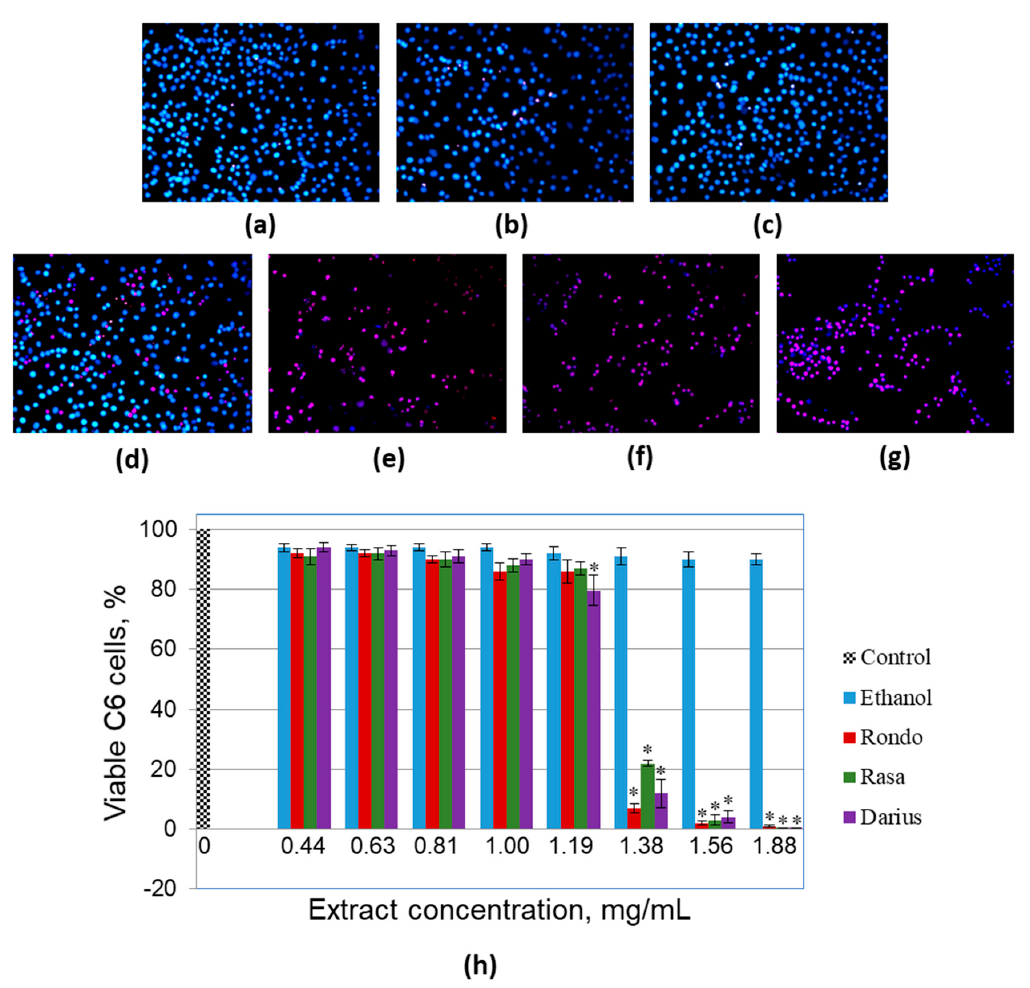
Figure 2. The effect of the extracts from leaves of different Japanese quince cultivars on viability of glioblastoma C6 cells. ( a – g ) Characteristic images of Hoechst/propidium iodide staining of the C6 cell nuclei after extract treatments; ( a ) samples treated with 125 µL/mL of the solvent ethanol (amount corresponds to 1.88 mg/mL extract treatment); ( b ), ( c ) and ( d ) treated with 1.19 mg/mL extracts from ‘Rondo’, ‘Rasa’, and ‘Darius’ cultivars, respectively; ( e ), ( f ) and ( g ) samples, after treatment with 1.56 mg/mL extracts from ‘Rondo’, ‘Rasa’, and ‘Darius’ cultivars, respectively; ( h ) quantitative summary of viability data presented as averages with standard deviation, * indicates significant difference compared with ethanol- only treated samples, p < 0.05.